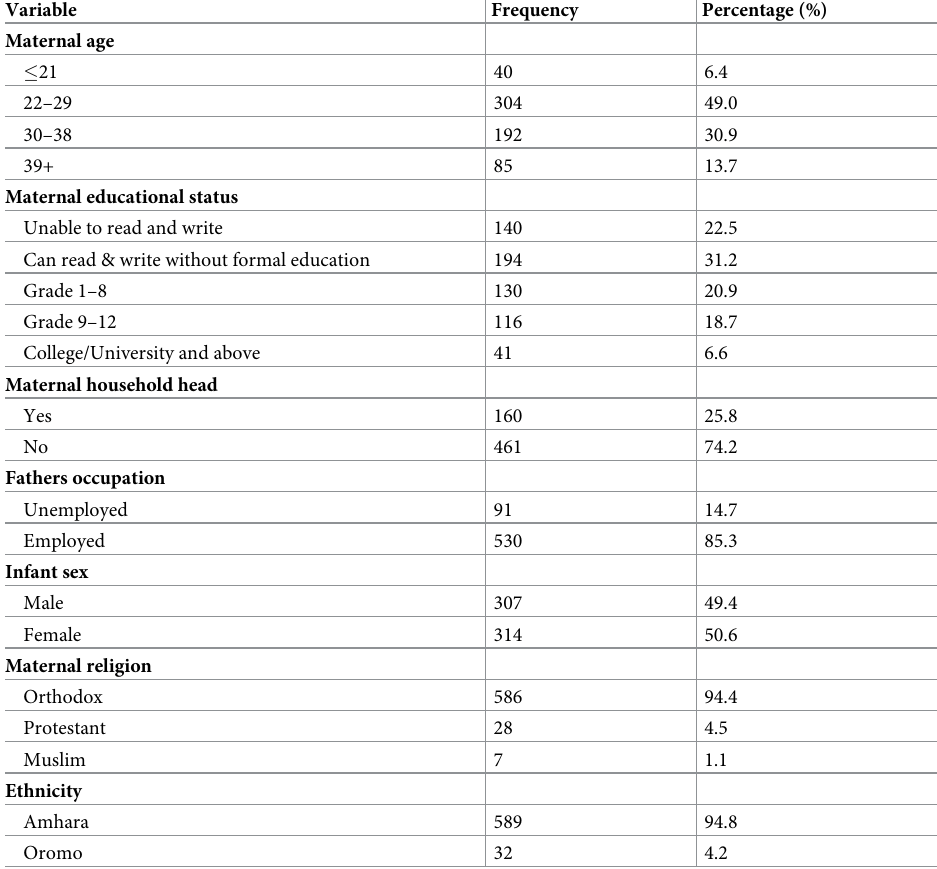
Table 1. Socio-demographic characteristics of mothers children aged less than six months in Bure District, Amhara Region, North West, Ethiopia, 2019 (n =